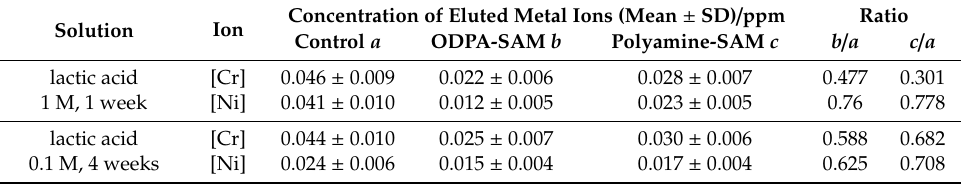
Table 3. Concentration of eluted metal ions from the modified wire immersed to lactic